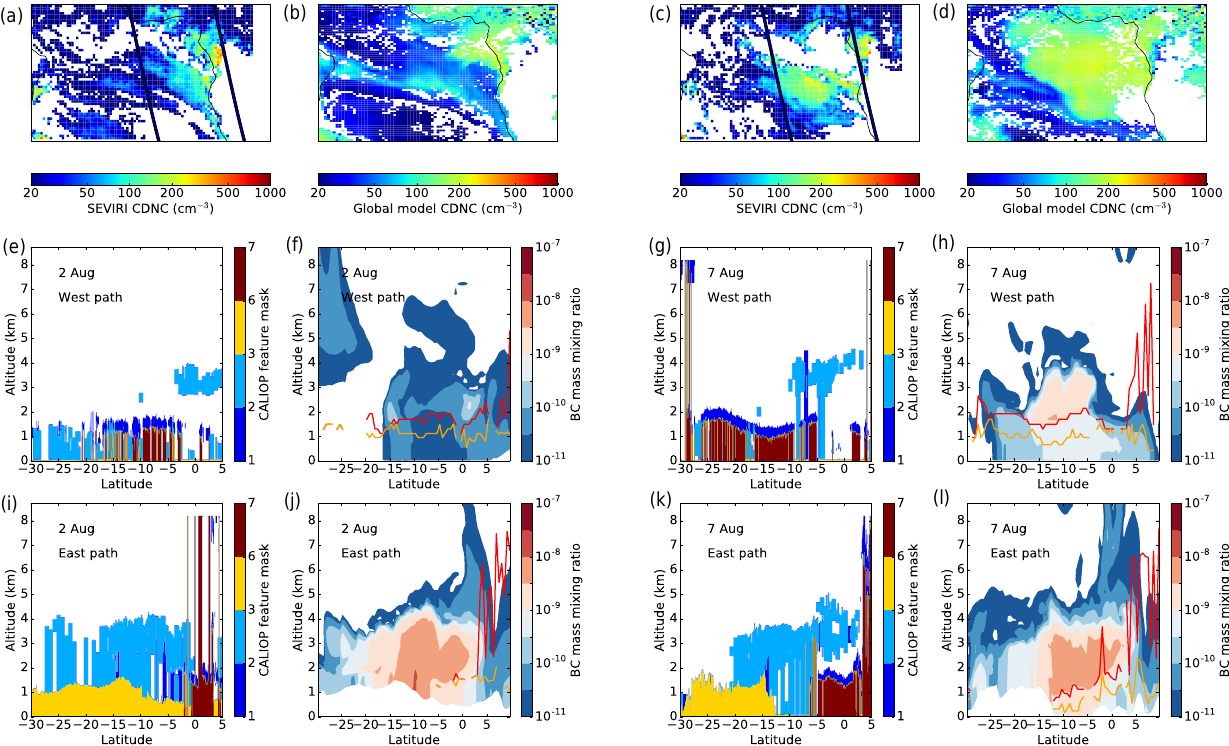
Figure 4. Evaluation of aerosol and cloud in the global model. Cloud droplet number concentrations from the SEVIRI satellite instrument and from the model are shown on the top row. In both the model and the observations, grid boxes with liquid water path less than 10gm − 2 are assumed to be cloud-free and are excluded, after degrading the resolution of the satellite to be comparable to the model. The left column shows SEVIRI CDNC, and, below this, the CALIOP feature mask for the marked easterly and westerly overpasses on 2 August (as for the trajectory plots). The second column shows the model CDNC and, below this, the simulated black carbon mass mixing ratio, used here as a proxy for smoke aerosol. The red line denotes the altitude of the cloud top and the orange line that of cloud base. The right two columns show the same, but for 7 August. In the feature mask, 1–2 (dark blue) indicates cloud, 2–3 (light blue) aerosol, 3–6 (yellow) land above sea level and 6–7 (dark red) indicates that the signal is fully